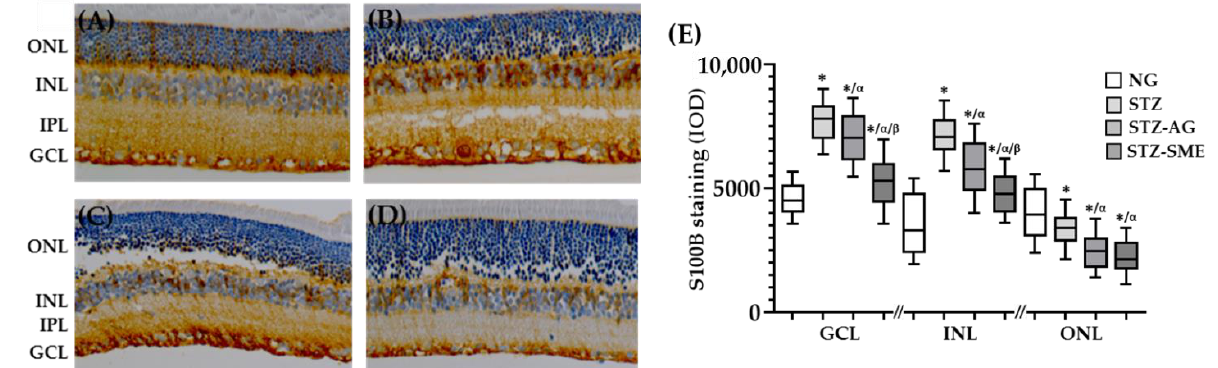
Figure 5. The S100 calcium-binding protein B (S100B) levels in the retina of the STZ. Retina sections were stained with anti-S100B in the NG ( A ), STZ ( B ), STZ-AG ( C ), and STZ-SME ( D ) groups. ( E ) Shows the box-and-whisker plot of the IOD for S100B protein staining in the three retinal layers for all groups. * p < 0.01 compared to NG; α p < 0.01 compared to STZ; and β p < 0.01 compared to STZ-AG. Magnification 200×.